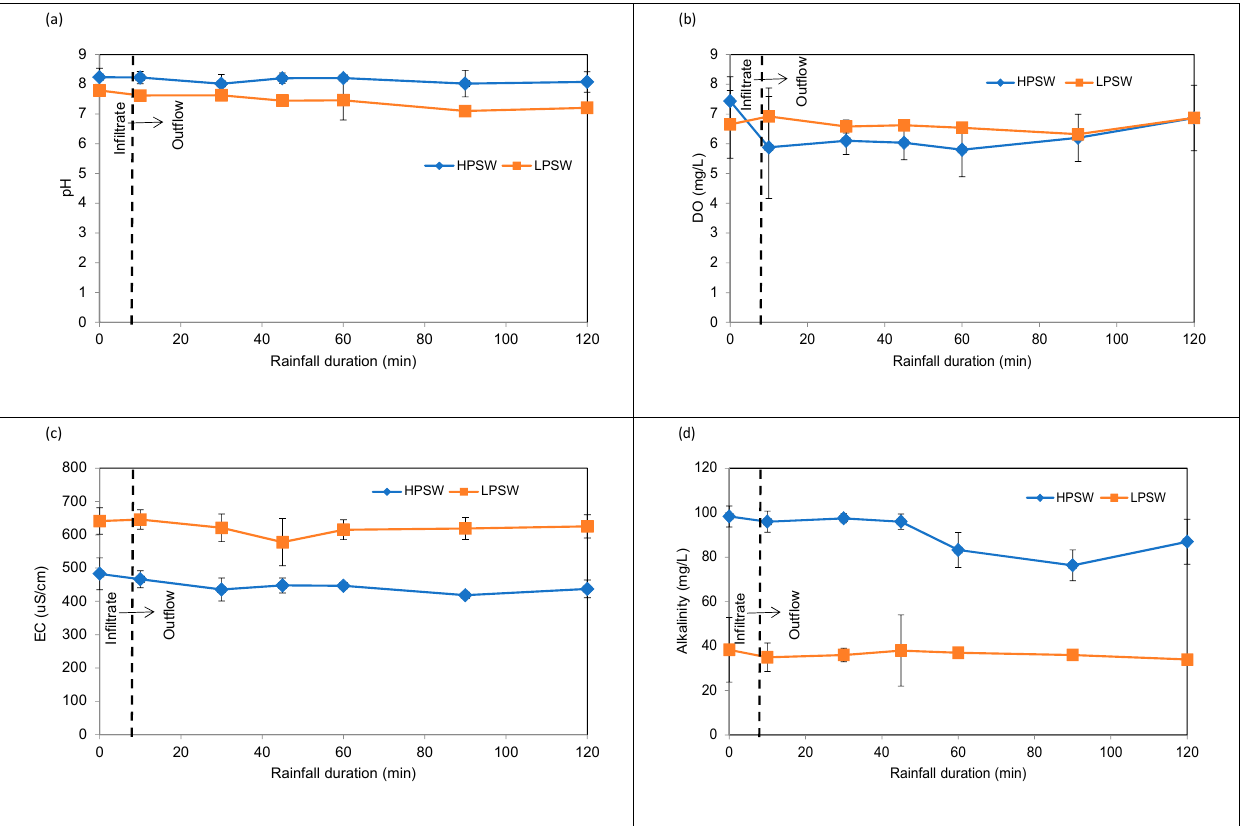
Figure 3. Variations of ( a ) pH, ( b ) DO, ( c ) alkalinity, and ( d ) EC before and after infiltration through permeable bricks.